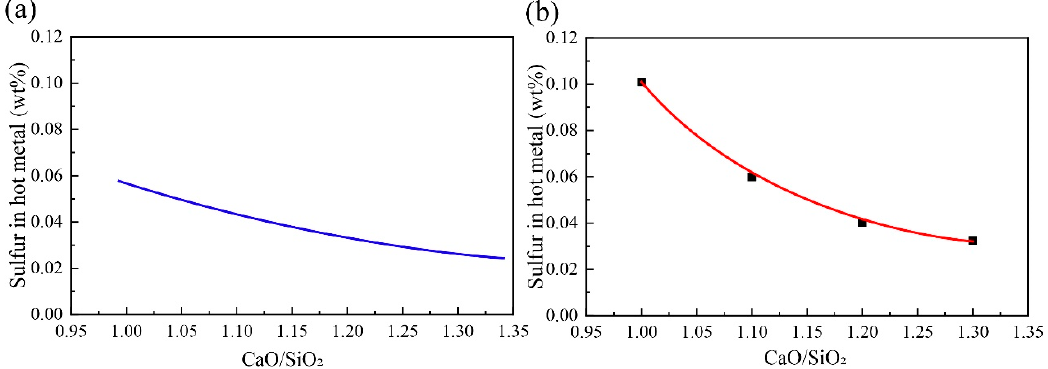
Figure 7. The effect of the CaO/SiO 2 on the desulfurization at slag-to-metal ratio of 200 kg/t, ( a ) FactSage calculation, ( b ) experimental results.